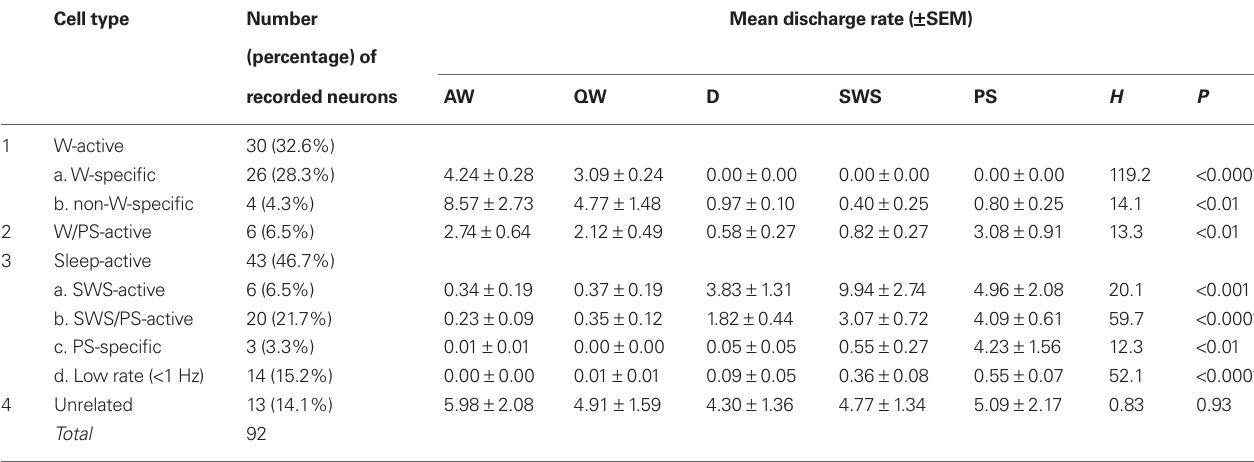
Table 1 | Cell counts and mean discharge rates during the sleep-waking cycle of state-dependent and state-unrelated ventral tuberomammillary neurons in wild-type mice.